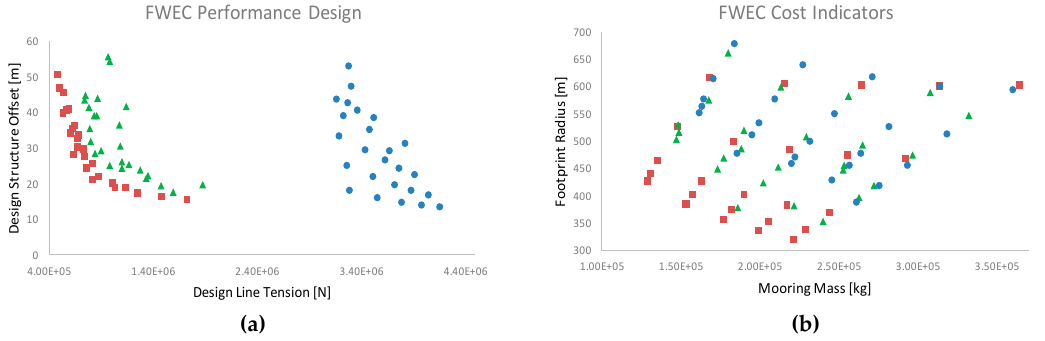
Figure 16. Design (a) and cost (b) spaces for the FWEC structure with the QSFD (red squares), QSTD (green triangles), and DynTD (blue circles) models. The mooring total mass and the footprint radius show increasing values as the complexity of